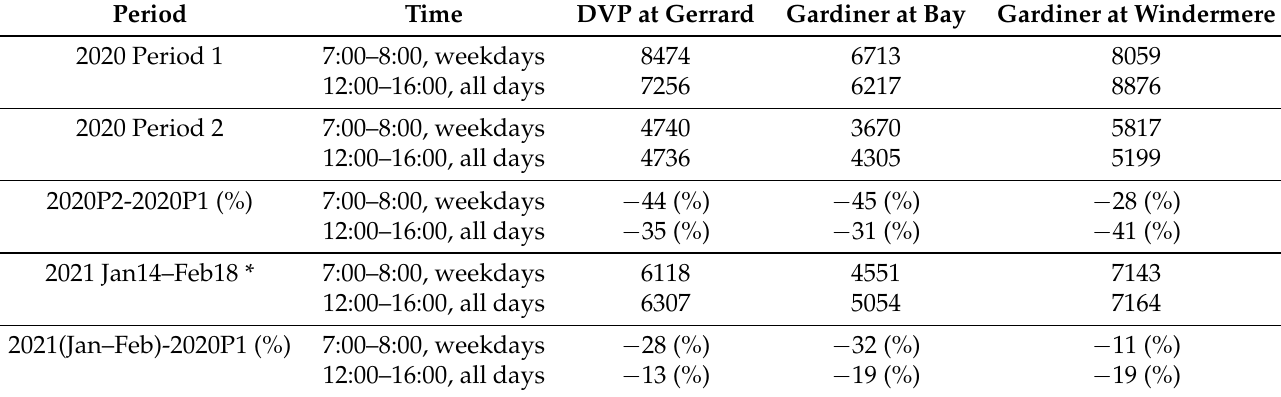
Figure 9. Locations of the OP-FTIR system and three sites for traffic data from the City of Toronto. The map was retrieved from Google Earth Pro on 14 April 2021. Table 4. Average hourly traffic counts at the Don Valley Parkway or Gardiner Expressway with Gerrard Street, Bay Street, and Windermere Avenue in downtown Toronto in 2020 and 2021. * Due to the availability of traffic data, this period is shorter than the 2021 Period 3 in Table